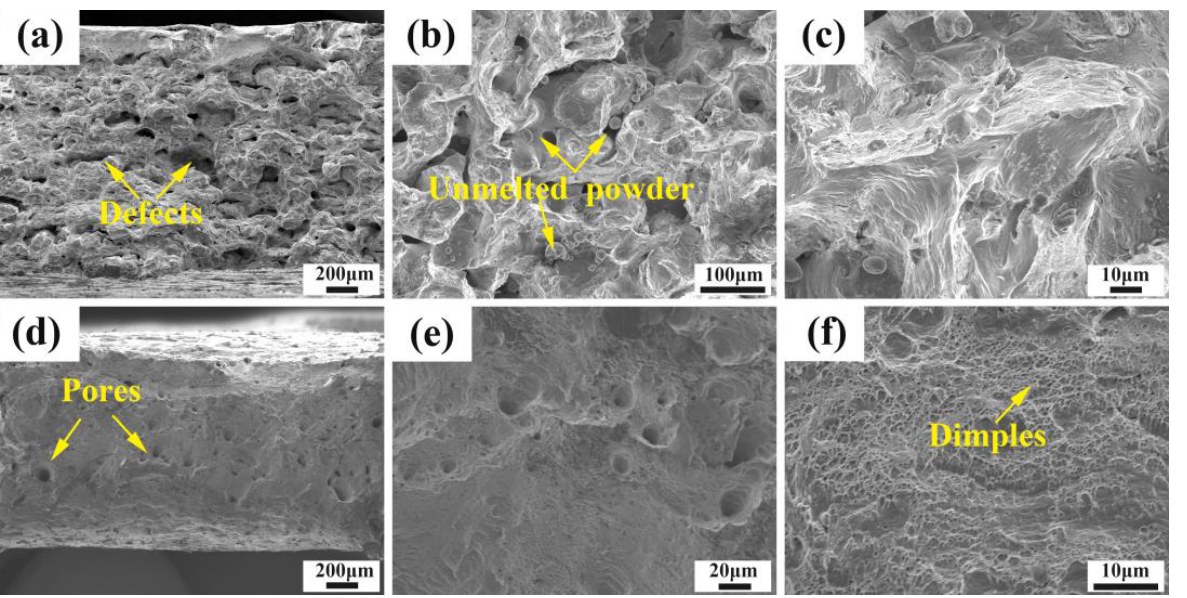
Figure 10. SEM images of the fracture morphologies of the tensile parts from ( a – c ) No.4 and ( d – f ) No.14.